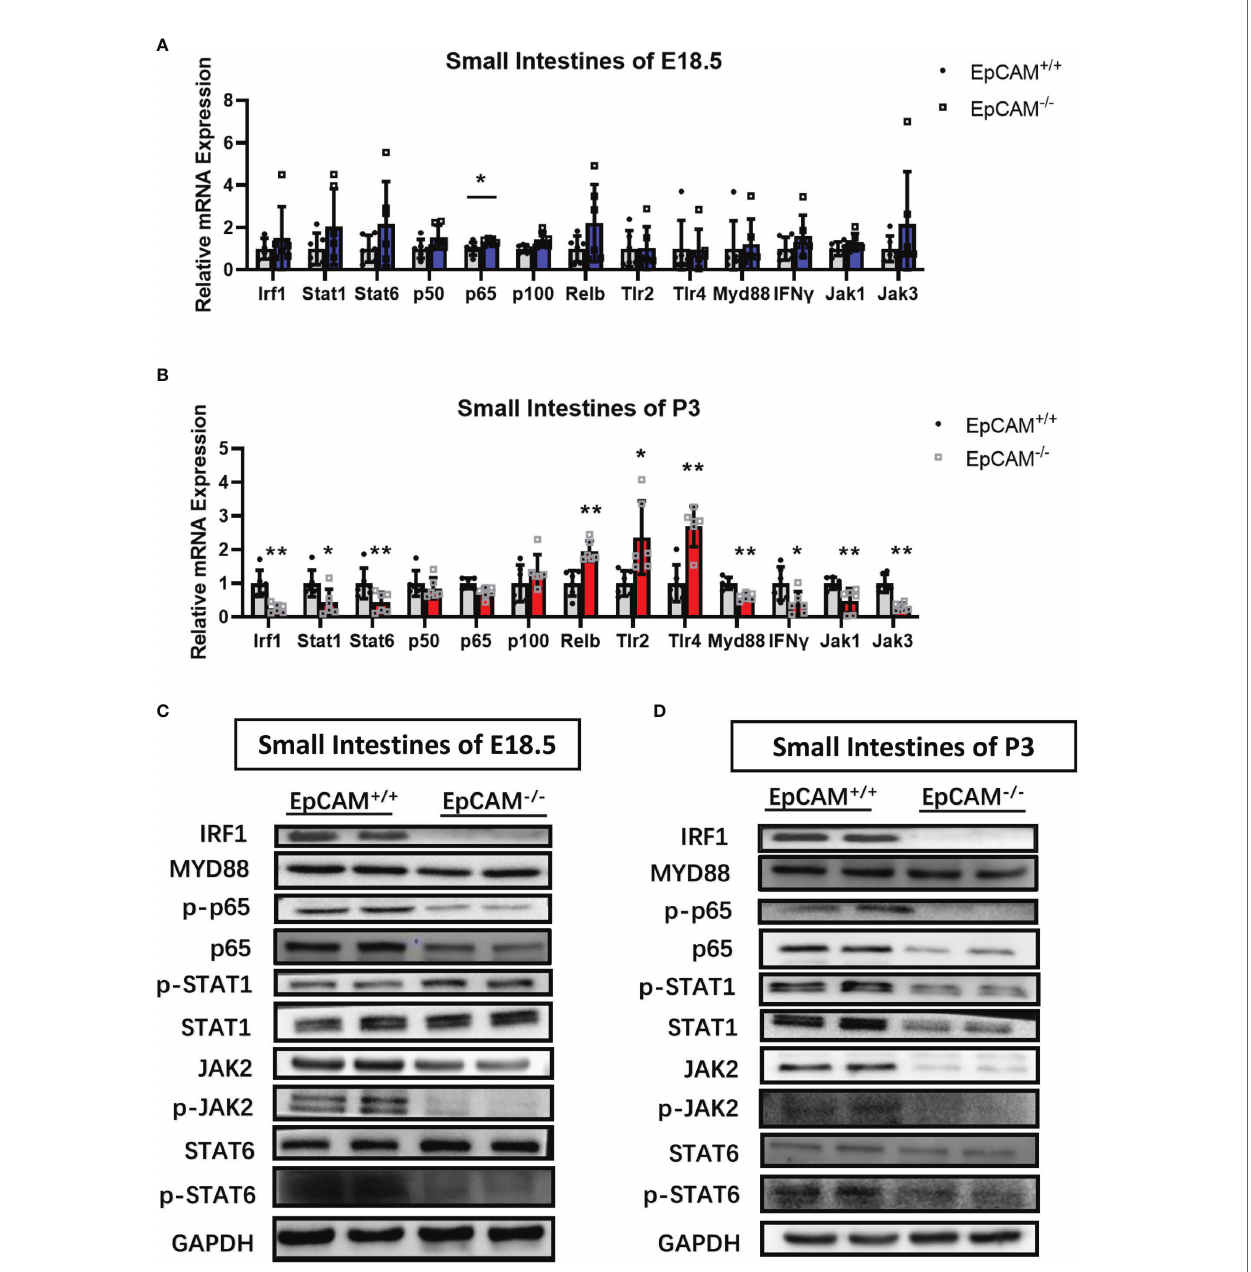
FIGURE 6 | EpCAM de fi ciency caused the changes of signaling pathways which regulate the expression of pIgR in the epithelial cells from the small intestines of mice. (A, B) Graphs showed the qPCR results of Irf1, Stat1, Stat6, p50, p65, p100, Relb, Tlr2, Tlr4, Myd88, IFN g , Jak1 and Jak3 in the small intestines from WT and EpCAM -/- mice at (A) E18.5 and (B) P3 stages, respectively (n=6). (C, D) Western blot results of IRF1, p-STAT1, STAT1, p-JAK2, JAK2, MYD88, p-p65, p65, p- STAT6 and STAT6 in the small intestines from WT and EpCAM -/- mice at (C) E18.5 and (D) P3 stages, respectively (n=3). * p < 0.05, ** p < 0.01, as determined by Mann – Whitney U test. All error bars represent